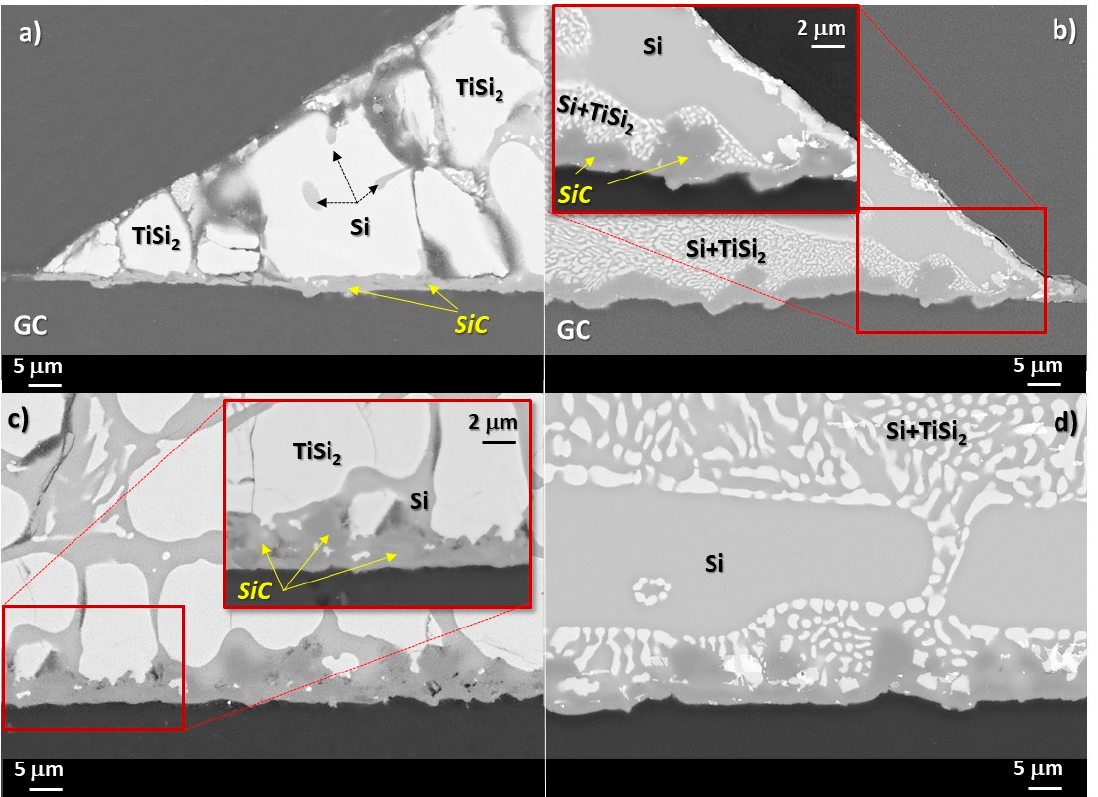
Figure 5. SEM-BSE images and proposed phase identification by EDS analyses performed at different magnifications at the triple lines and at the interfaces of the ( a , c ) cross-sectioned Si-24at%Ti/GC and ( b , d ) Si-8at%Ti/GC samples after the wetting tests performed at T = 1450 °C for 15 min.